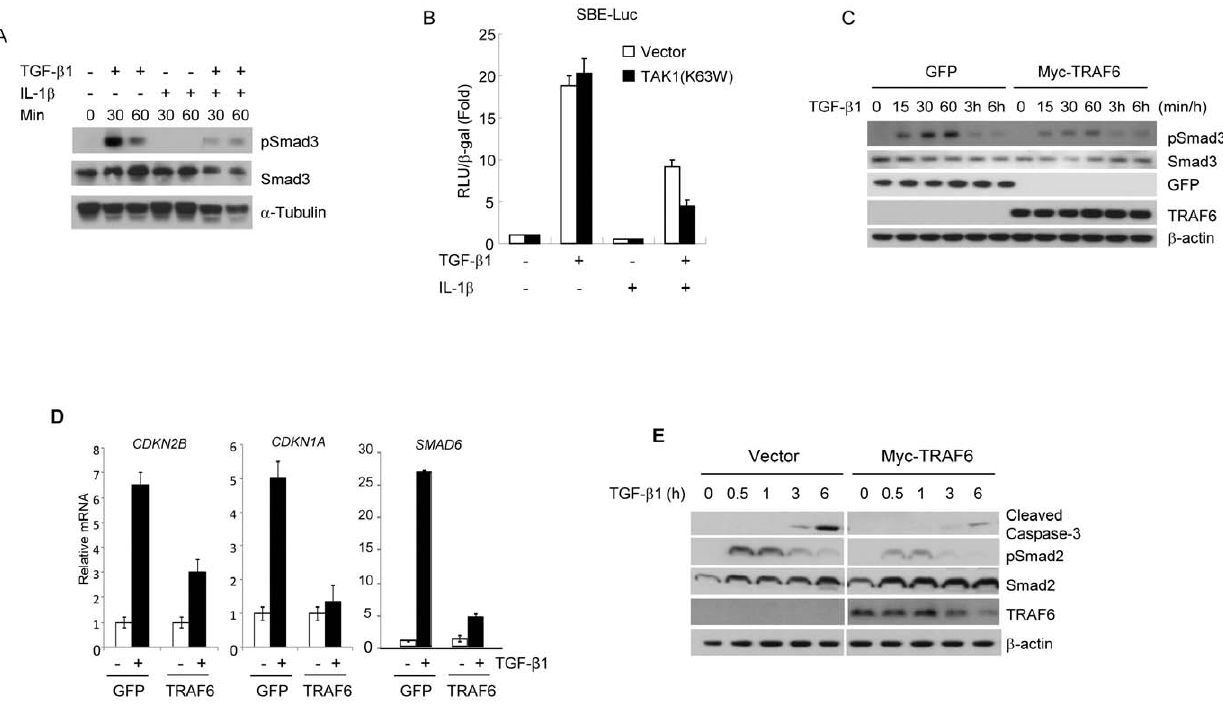
Figure 1. TRAF6 mediates IL-1 b or LPS-induced suppression of TGF- b 1/Smad pathway. ( A ) HEK293 cells were treated with TGF- b 1 (0.4 ng/ ml) and/or IL-1 b (2 ng/ml) as indicated. TGF- b -mediated Smad3 phosphorylation was demonstrated by anti-pSmad3 and total Smad3 antibodies. As a loading control, a -tubulin was used. ( B ) SBE-Luc assay was performed in HepG2 cells. These luciferase assays were normalized by the activities of co- transfected b -galactosidase. ( C ) TRAF6 or GFP was over-expressed in HEK293 cells by use of a lentiviral system. Cells were harvested after TGF- b 1 addition for up to 6 hours followed by westernblotting to compare phospho-Smad2/3 levels. ( D ) TGF- b 1 target genes, CDKN2B , CDKN1A , and SMAD6 , were detected by quantitative RT-PCR using total RNA from vector-(GFP) or TRAF6-expressing HaCaT cells treated as indicated. Human GAPDH was used as a loading control. ( E ) FaO cells were infected with either control vector or Myc-TRAF6 on previous day and then treated with TGF- b alone or together with LPS up to 8 hours. Both floating and adherent cells were harvested to compare the induction of cleaved caspase-3. TGF- b -induced signal transduction was displayed by showing pSmad2 level. The results are representative of three independent experiments.